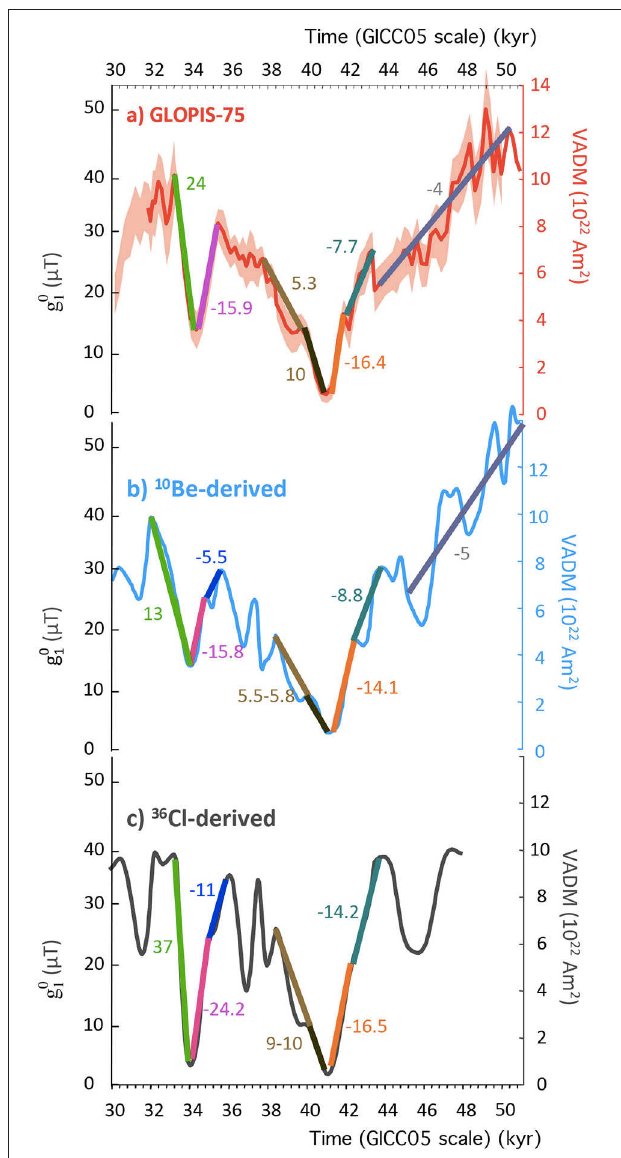
FIGURE 5 | GLOPIS-75 (A), Greenland 10 Be (B), and 36 Cl (C) derived curves on which the decay and growth rates of the geomagnetic dipole intensity are illustrated as colored lines. The numbers reported with the same colors as the lines are for the corresponding rates of change (in nT/yr) of the dipole field intensity (negative for decay and positive for growth). The intensity profiles are reported with two vertical scales: one in VADM (10 22 Am 2 ) and the other one in g 0 1 ( µ